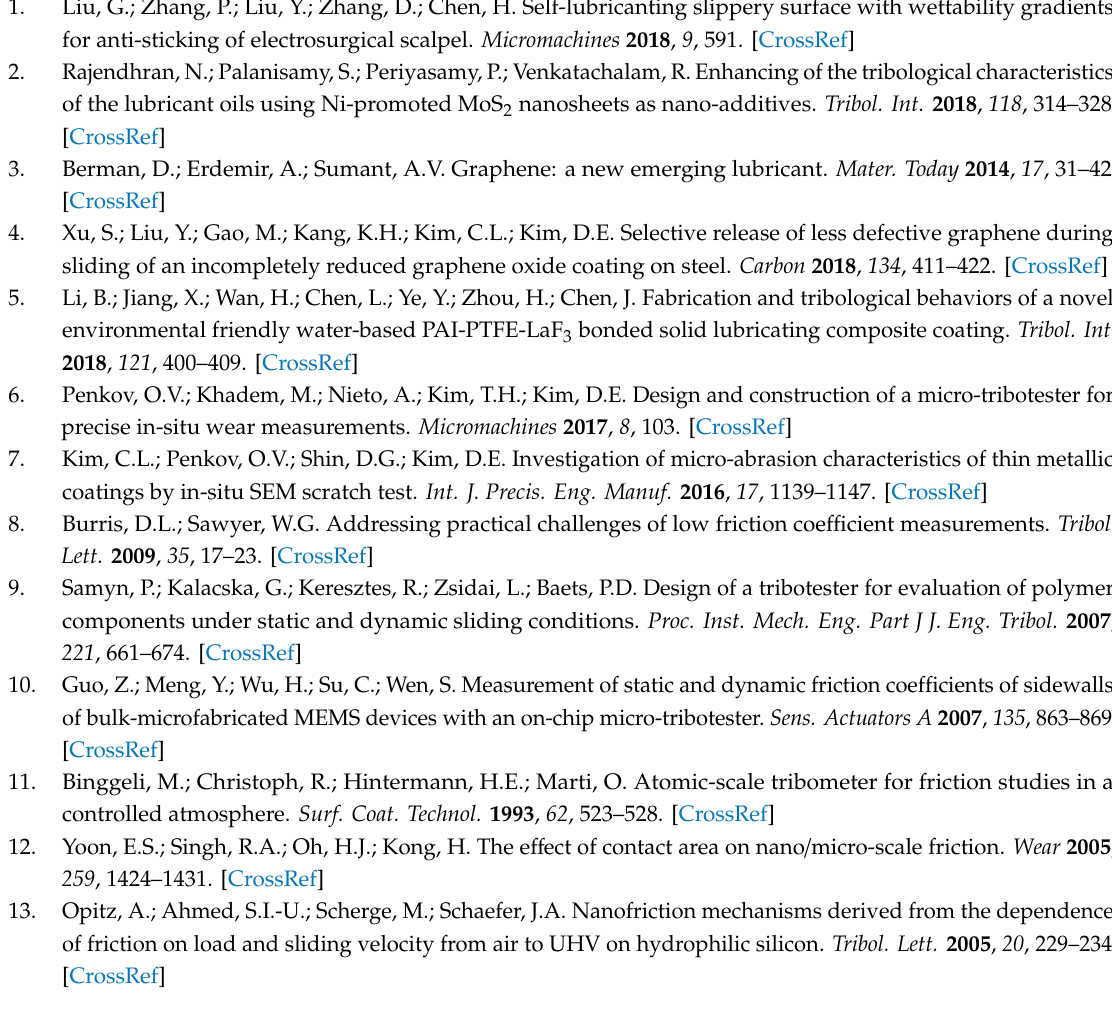
Figure S1: Displacement results for (a) Tip 2 and (b) Tip 3 depending on the normal forces (0.1, 0.5, 1.0, 2.0, and 3.0 mN) based on FEA simulations; Figure S2: Displacement results for (a) Tip 2 and (b) Tip 3 depending on the friction forces (0.1, 0.5, 1.0, 2.0, and 3.0 mN) based on FEA simulations; Figure S3: Pressure results for (a) Tip 2 and (b) Tip 3 depending on the normal forces (0.1, 0.5, 1.0, 2.0, and 3.0 mN) based on FEA simulations; Figure S4: Pressure results for (a) Tip 2 and (b) Tip 3 depending on the friction forces (0.1, 0.5, 1.0, 2.0, and 3.0 mN) based on FEA simulations; Figure S5: Pressure variations of Tip 2 and Tip 3 depending on the (a) normal forces and (b) friction forces, respectively (0.1, 0.5, 1.0, 2.0, and 3.0 mN); Figure S6: (a) Displacement and (b) pressure changes of Tip 3 depending on the friction force under a normal force of 0.1 mN; Figure S7: (a) Displacement and (b) pressure changes of Tip 3 depending on the friction force under a normal force of 0.5 mN; Figure S8: (a) Displacement and (b) pressure changes of Tip 3 depending on the friction force under a normal force of 1.0 mN; Figure S9: (a) Displacement and (b) pressure changes of Tip 3 depending on the friction force under a normal force of 2.0 mN; Figure S10: (a) Displacement and (b) pressure changes of Tip 3 depending on the friction force under a normal force of 3.0 mN; Figure S11: Relationship between the maximum pressure and normal / friction forces generated at the edge parts of the arms of the cantilever